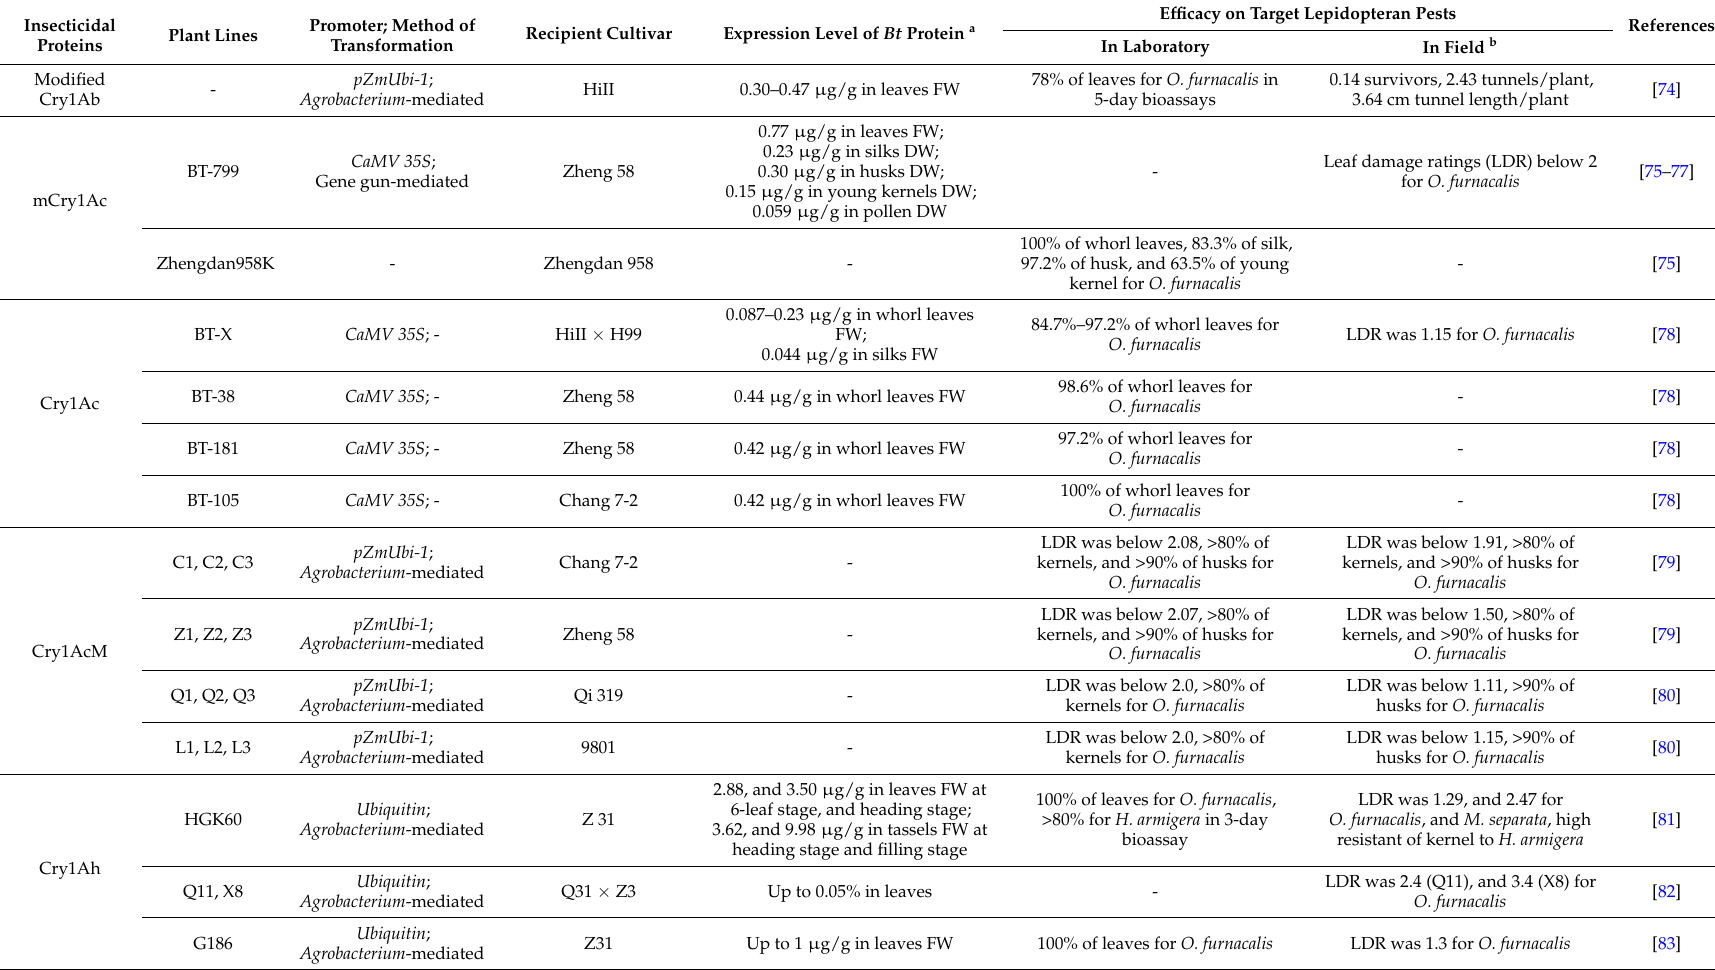
Table 2. Insect-resistant Bt maize lines and their efficacy on target lepidopteran pests in